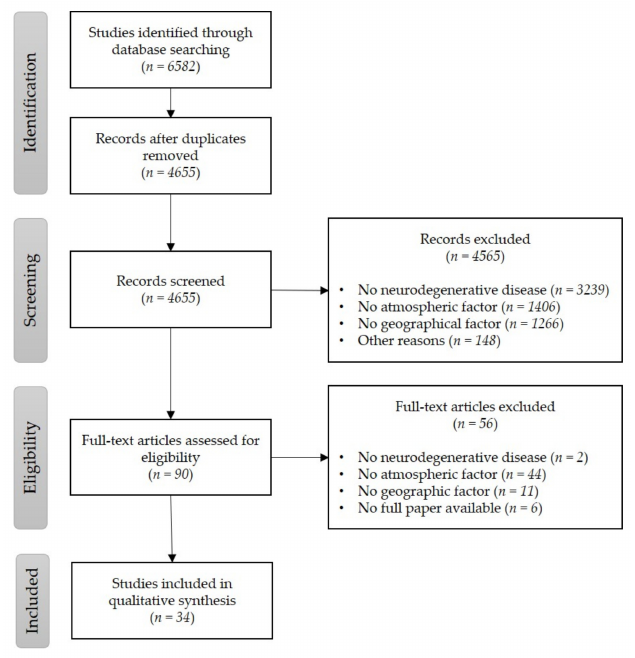
Figure 1. Systematic review PRISMA